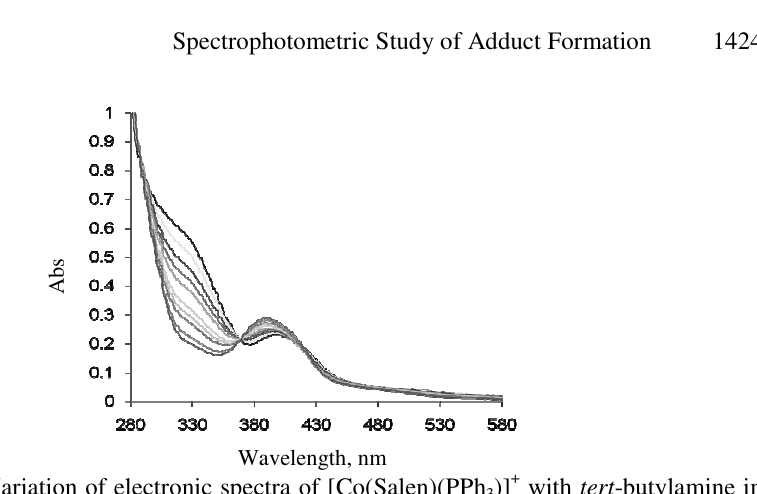
)] + with tert -butylamine in 3